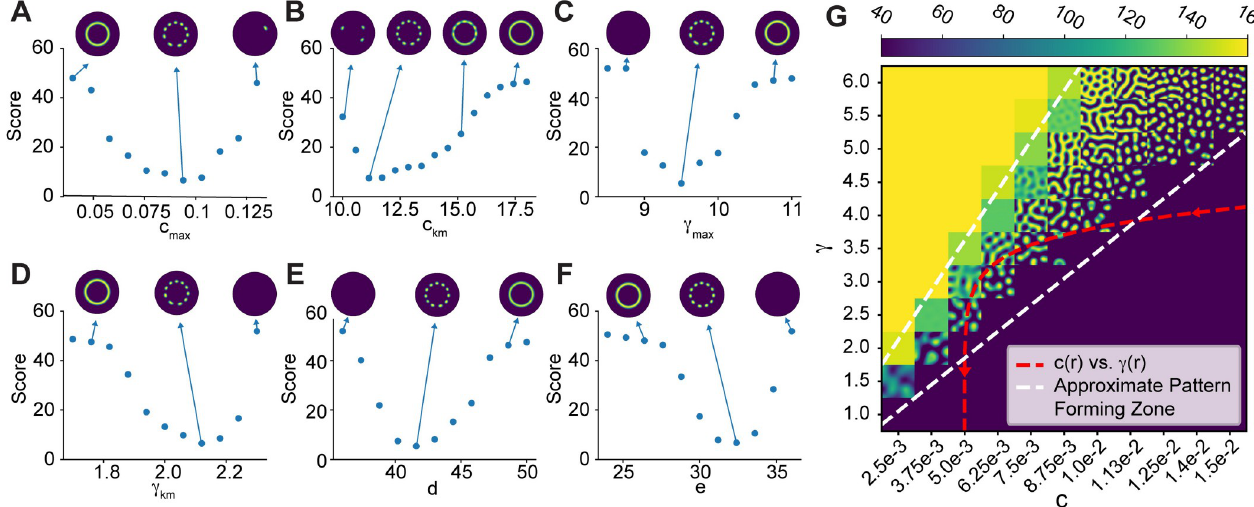
Fig 5. Effects of individual parameters on patterning. A-F) Plots of the score function versus model parameters (Table 2). Representative simulation results shown to illustrate the impact of varying parameter values on rosette formation. G) Two parameter sweep varying c and γ . Each grid cell shows the active GTPase concentration for an individual simulation when c and γ are fixed. The red dashed line is a plot of c(r) versus γ (r) from Fig 4E and Table 2.